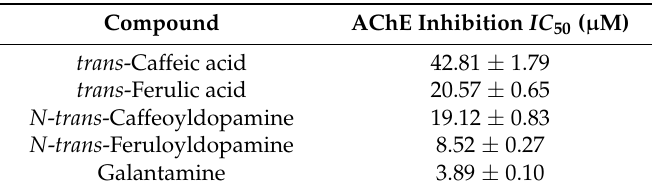
Table 1. In vitro inhibition of acetylcholinesterase